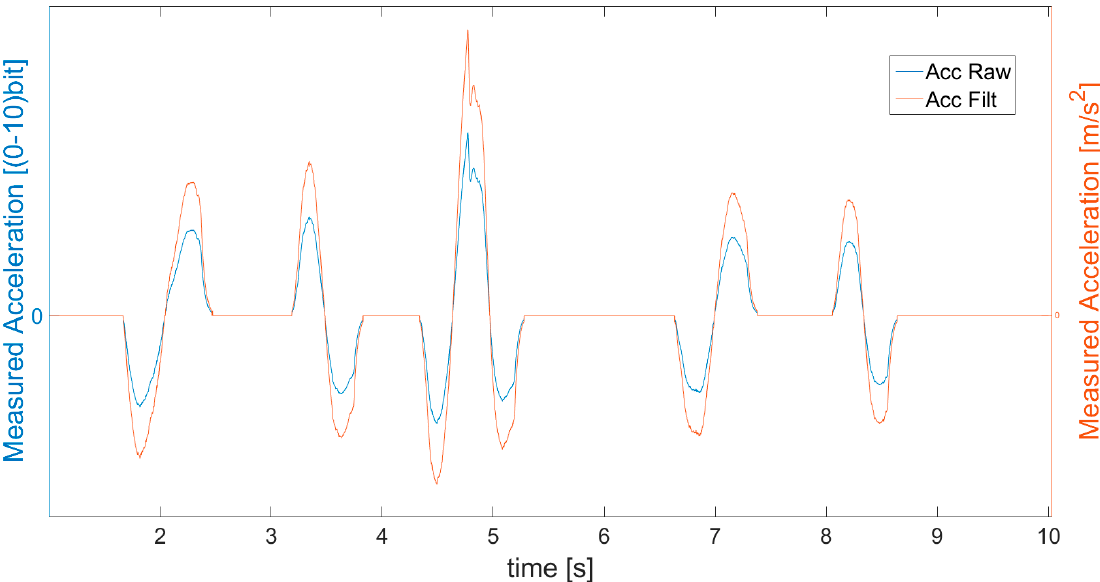
Figure 5. Measured acceleration (blue line) and data after bias subtraction, saturation, scaling and filtration (red line—